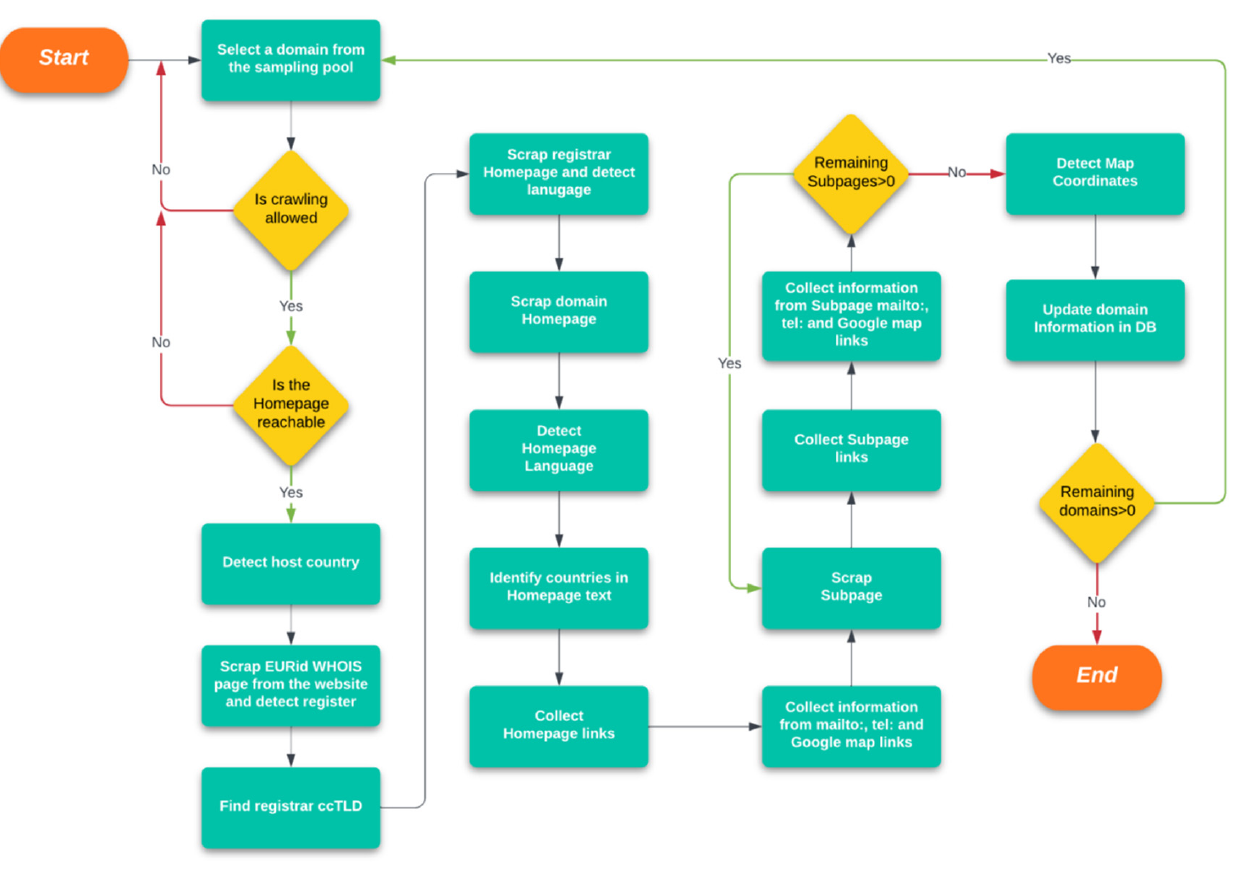
Figure 4. Flowchart of the Web data extraction algorithm.